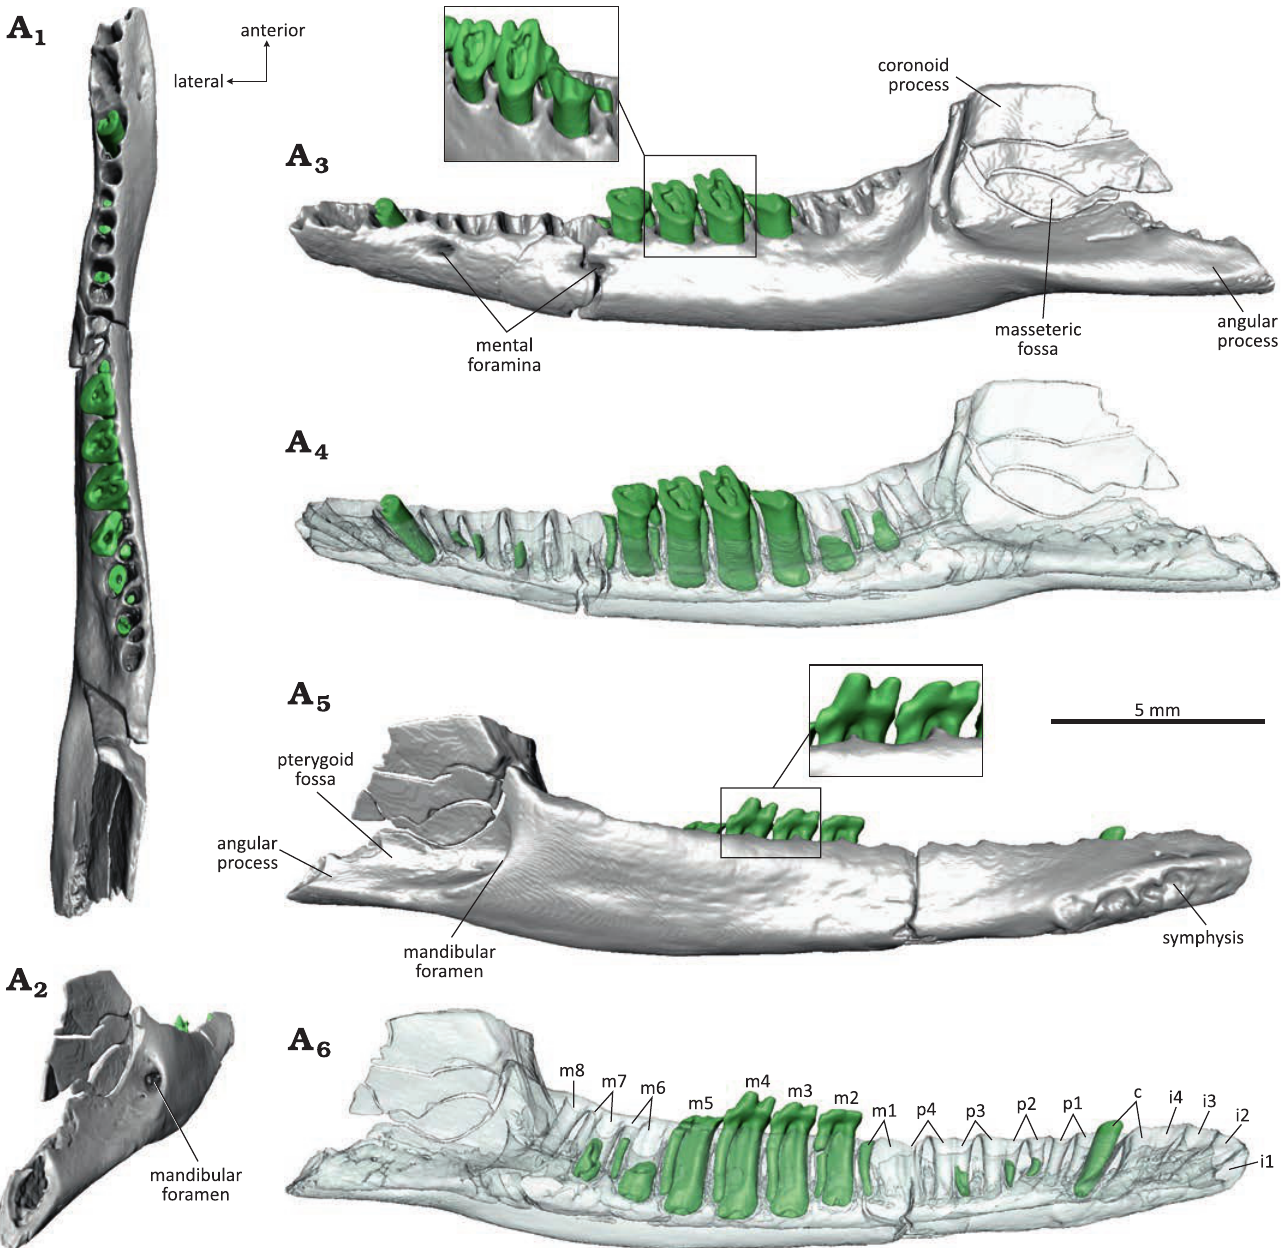
Fig. 9. Dryolestid mammal Beckumia sinemeckelia gen. et sp. nov., WMNM P82301 (holotype) from Busche Quarry near Balve, North Rhine-Westphalia, Germany, Barremian–Aptian (Lower Cretaceous). Left mandible in dorsal (A 1 ), linguoposterior (A 2 ), lateral (A 3 , A 4 ), and medial (A 5 , A 6 ) views. Inset in A 3 showing enlarged m3–m5 in distolabial view, inset in A 5 showing m3 and m4 in lingual